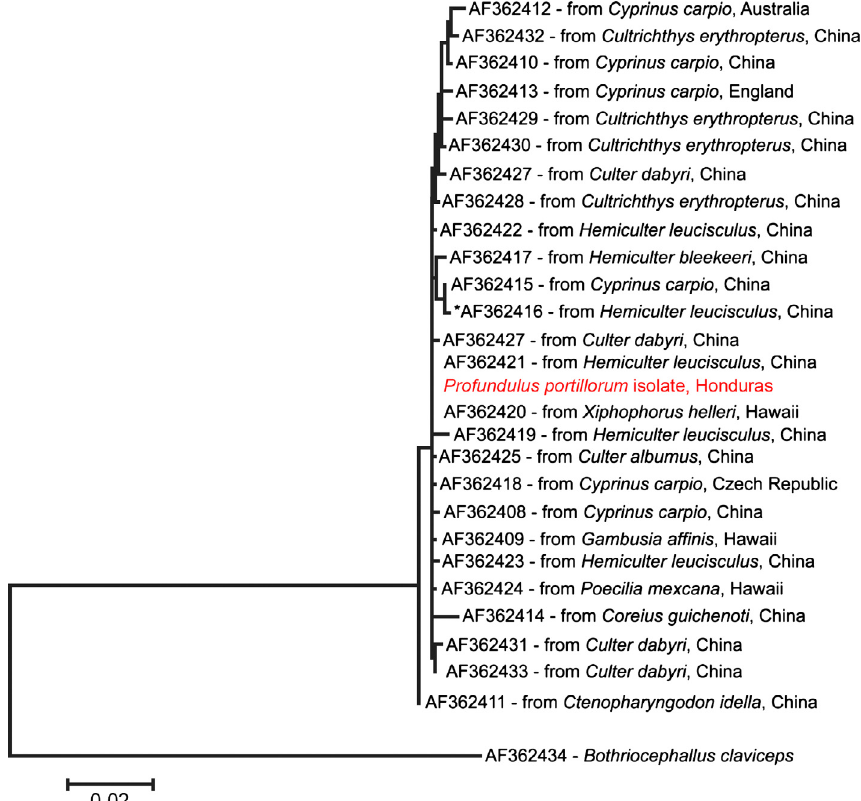
Figure 2. The phylogenetic tree produced by the maximum likelihood analysis of sequences used in this study. Sequences from Luo et al. (2002) are identified by their GenBank Accession Number, the fish species from which the specimen was isolated, and the geographic location of the collection. The label ‘‘ Profundulus portillorum isolate’’ identifies the sample from Honduras. The asterisk marks the only branch within the ingroup with greater than 85% bootstrap